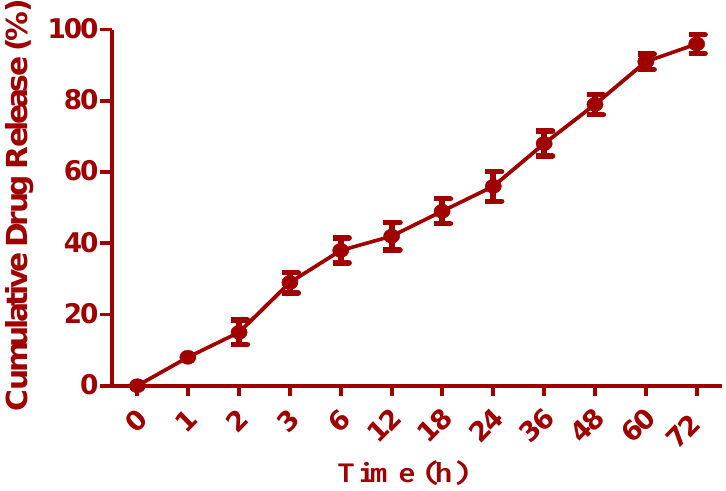
Figure 6. In vitro dissolution profile of optimized formulation of PT.